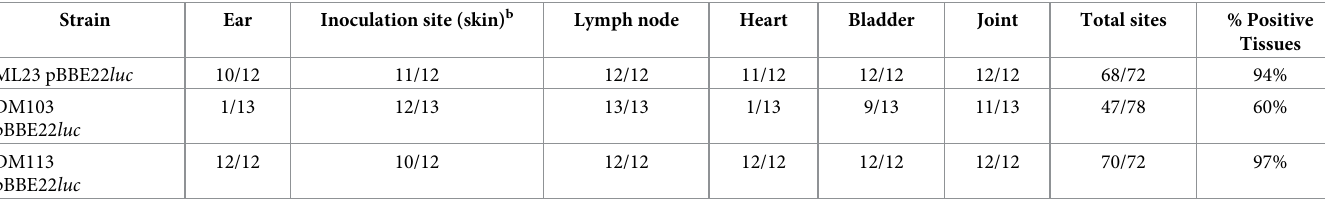
a Dose of 10 3 per strain of B . burgdorferi tested. b Skin from abdomen (inoculation